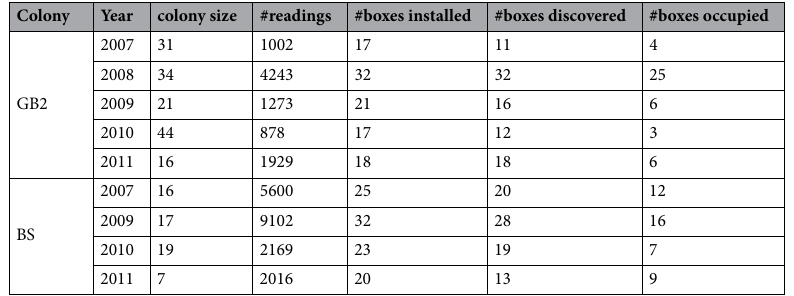
Table 1. Data summary. A box is defined as discovered, if at least one naïve individual is recorded in it during the season. When at least 2 bats (minimum number for a group decision) used a new box as a day roost, this box was considered occupied by a group of